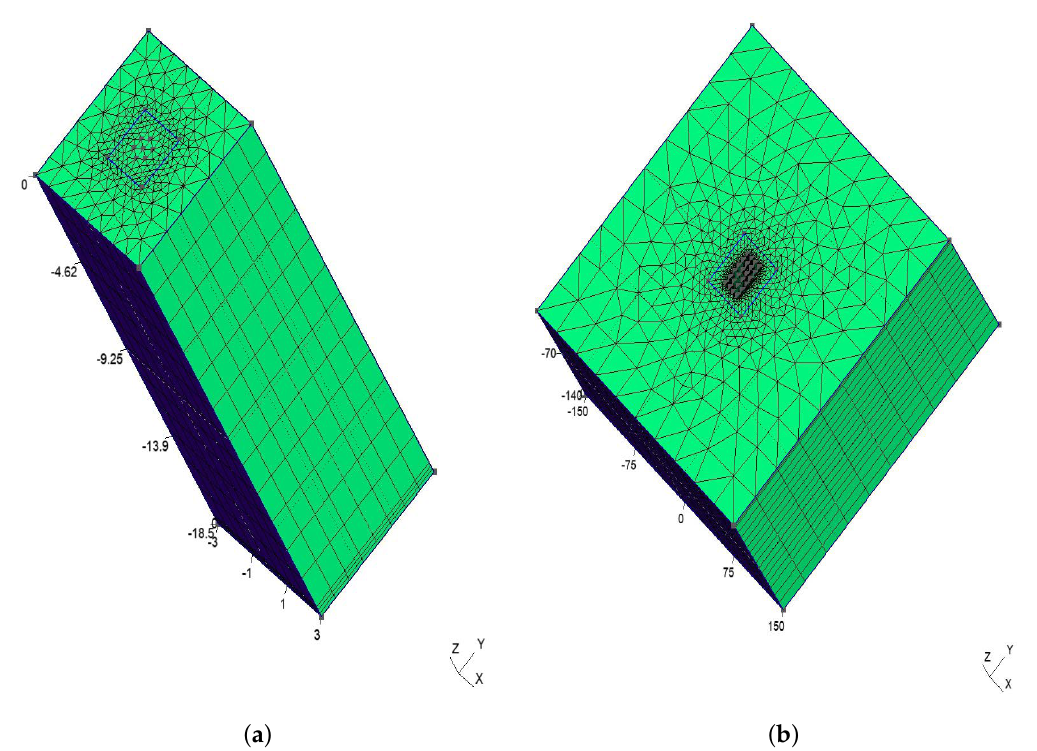
Figure 4. Finite element discretization for model validation. ( a ) Mesh for Beier’s experiment. ( b ) Mesh for a borefield with 24